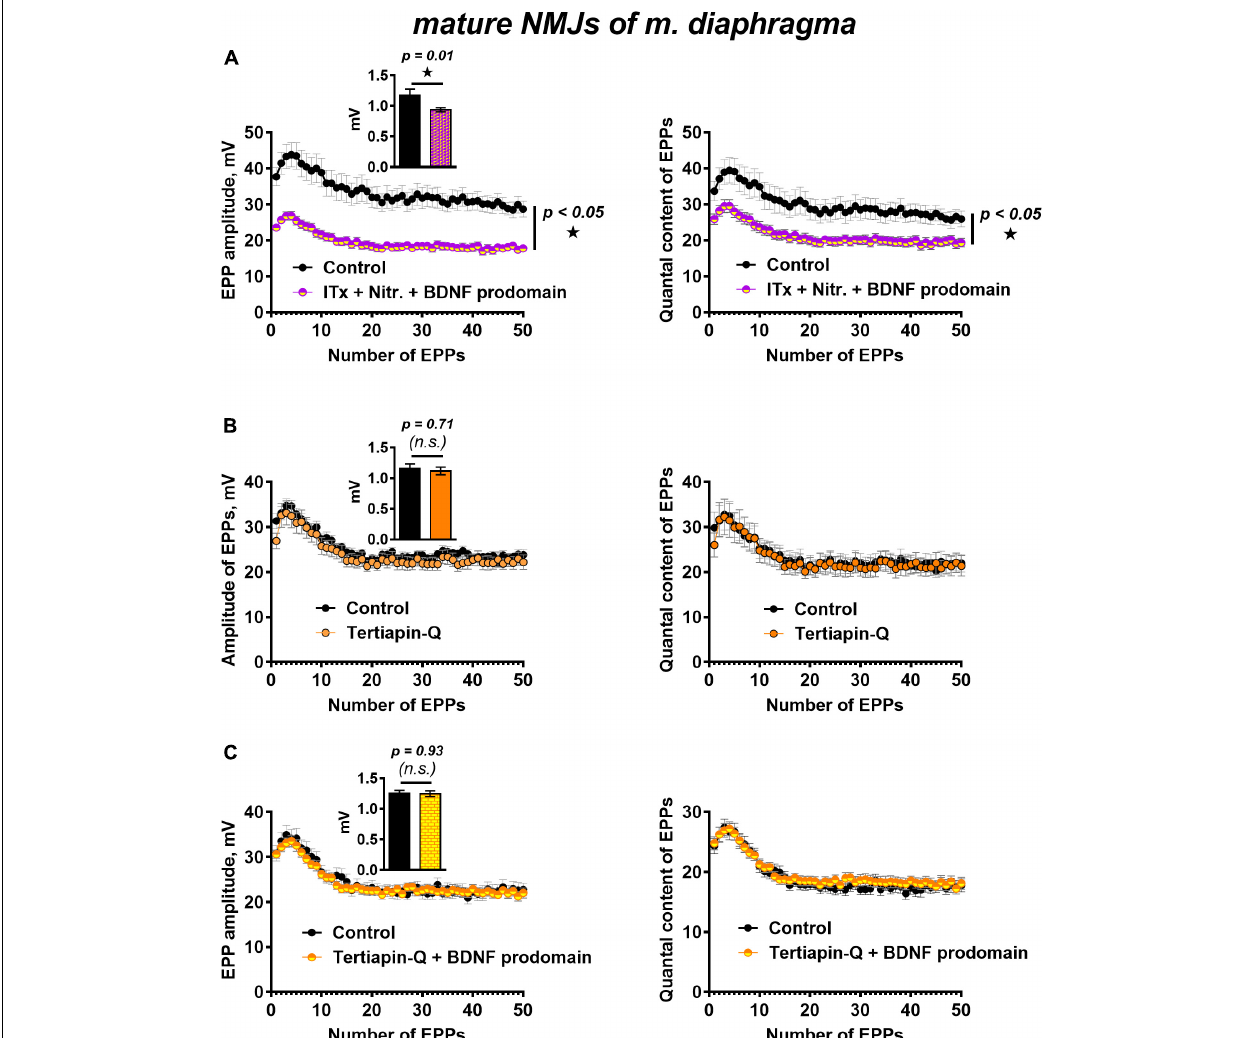
FIGURE 5 | BK channels do not but GIRK channels mediate BDNF prodomain-induced inhibition of evoked ACh release at mature NMJs. (A) Changes in the EPP amplitude (left) and in the quantal content of EPPs (right) in control ( n = 15) and upon BDNF prodomain (1 nM) in the presence of BK-blocker iberiotoxin (ITx, 100 nM) with L-type Ca 2 + -channel blocker nitrendipine (Nitr., 1 µ M) ( n = 21). (B) Changes in the EPP amplitude (left) and in the quantal content of EPPs (right) in control ( n = 15) and in the presence of GIRK blocker tertiapin-Q (100 nM, n = 17). (C) Changes in the EPP amplitude (left) and in the quantal content of EPPs (right) in control ( n = 16) and upon BDNF prodomain (1 nM) in the presence of tertiapin-Q ( n = 19). Insets show MEPP